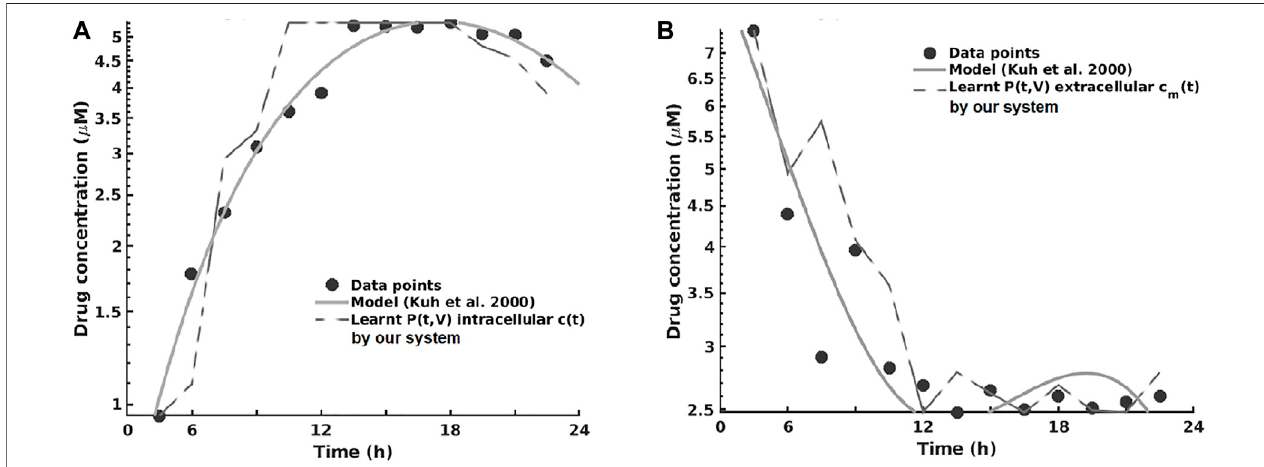
FIGURE 8 | Learning the pharmacokinetics of the intracellular (A) and extracellular (B) paclitaxel concentration. Data from Kuh et al. (2000), log scale plot.